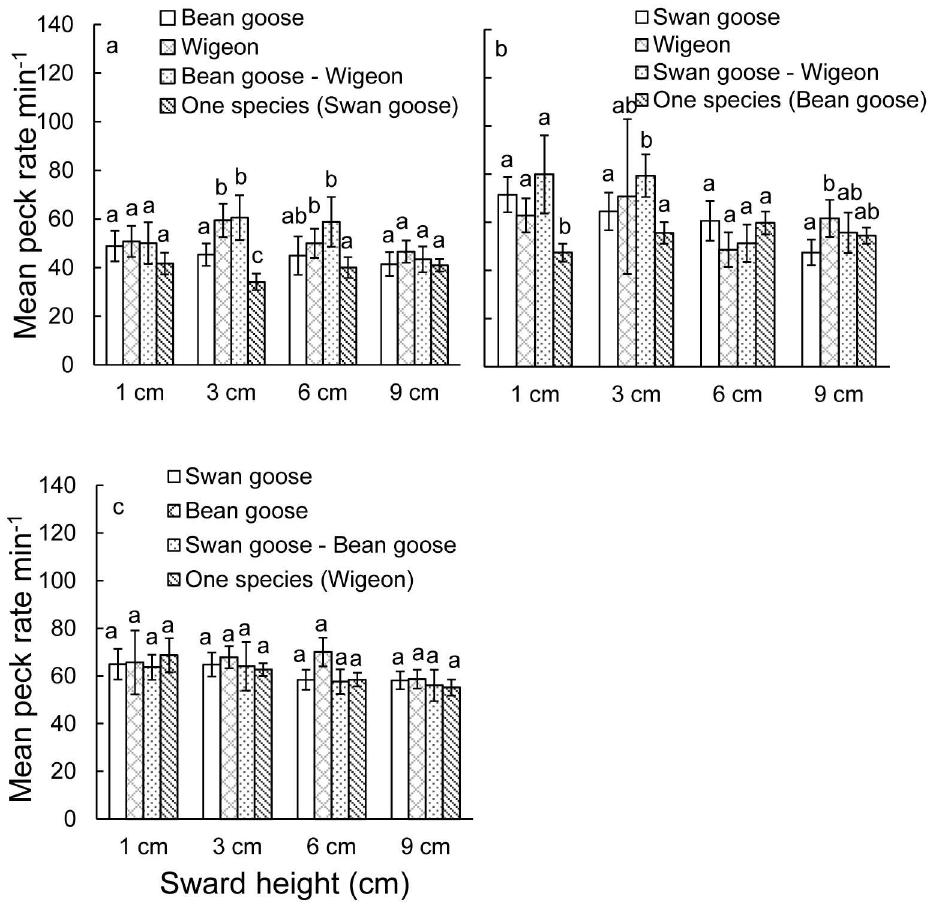
Fig 4. Mean peck rates ( ± 95% CI, untransformed data) in plots of different sward heights and with differently sized competitors a: swan goose, b: bean goose; c: wigeon. Different letters represent the results of the Tukey post-hoc test, which indicate differences between peck rate between competitors within the sward height